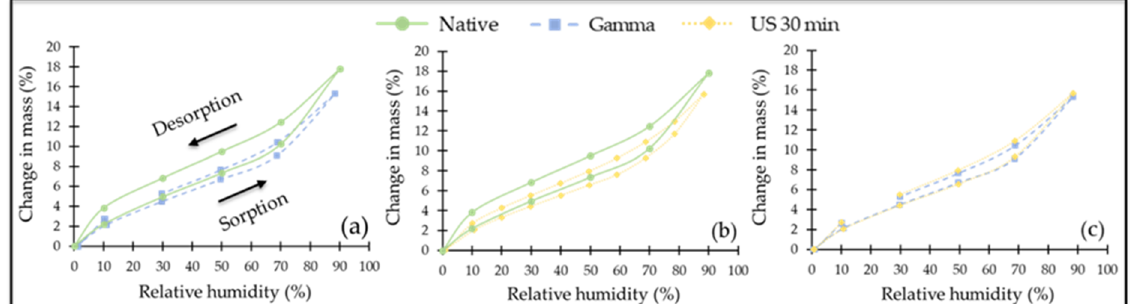
Figure 7. Comparison of sorption-desorption curves for ( a ) Native and Gamma samples; ( b ) Native and US 30 min samples; ( c ) Gamma and US 30 min samples.